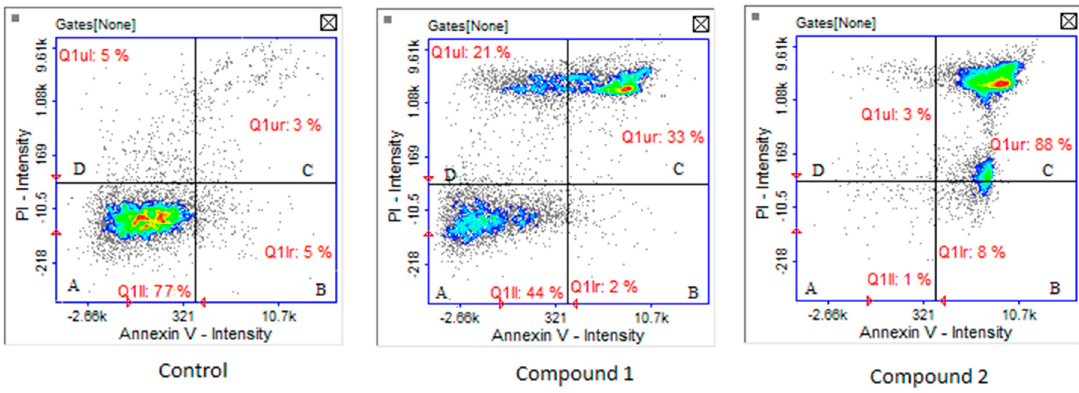
Figure 6. Cell apoptosis/necrosis of MKN74 cells, stained with Annexin V-FITC and PI for image cytometry, analyzed by NucleoCounter NC-3000. ( A ) Live, ( B ) early apoptotic, ( C ) late apoptotic, and ( D ) necrotic cells. The cells were treated with compounds 1 and 2 (250 µM) for 24 hours. Cell cycle analysis by image cytometry revealed that both compounds arrested cell cycle.